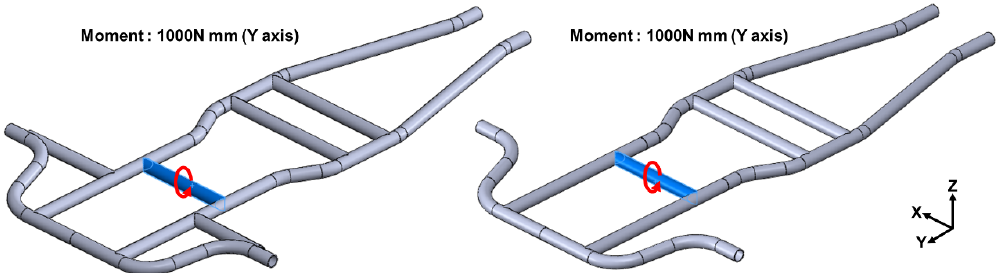
Figure 21. Frame (with/without stiffeners) – application end.